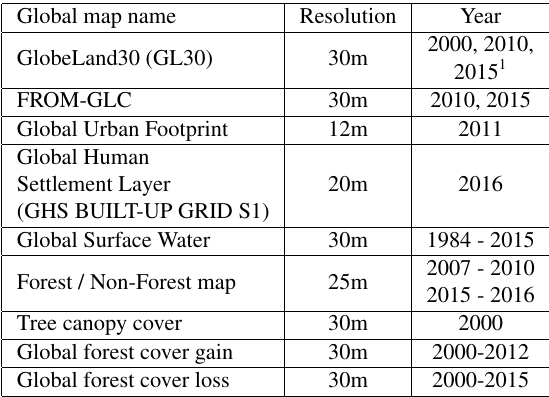
Table 1. Existing high-resolution global land cover